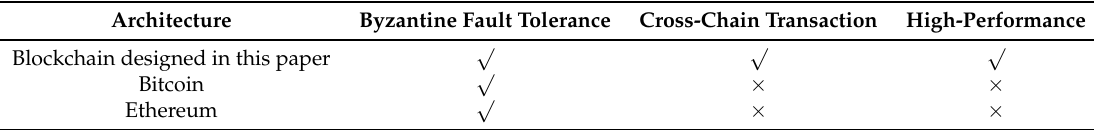
Table 10. Comparison with Bitcoin and